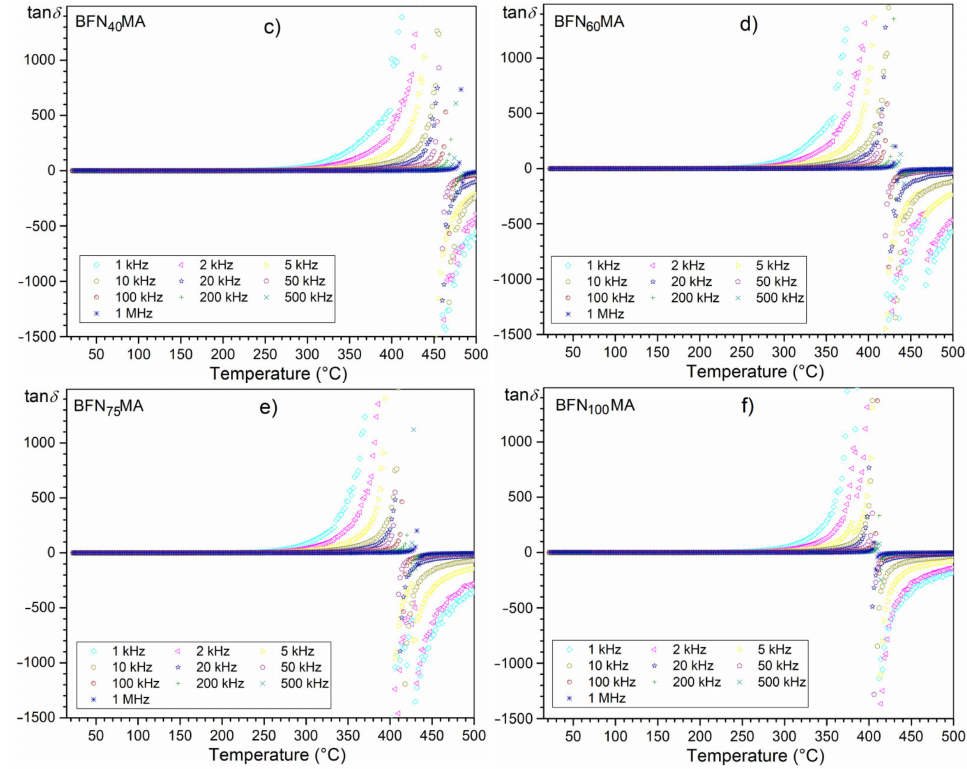
Figure 8. Temperature dependencies of dielectric loss for BFN x MA ceramic samples: BFN 10 MA ( a ), BFN 20 MA ( b ), BFN 40 MA ( c ), BFN 60 MA ( d ), BFN 75 MA ( e ), and BFN 100 MA ( f ) in a wider measuring